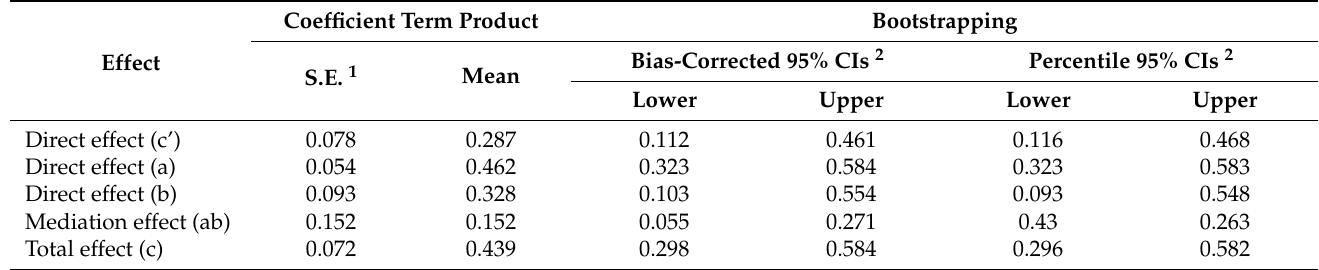
Table 10. Results of symbiotic unit, model and effect mediation